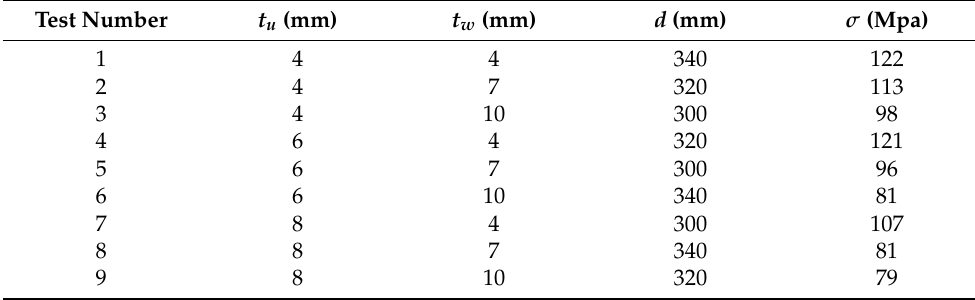
Table 2. Orthogonal experiment data of L 9 (3 4